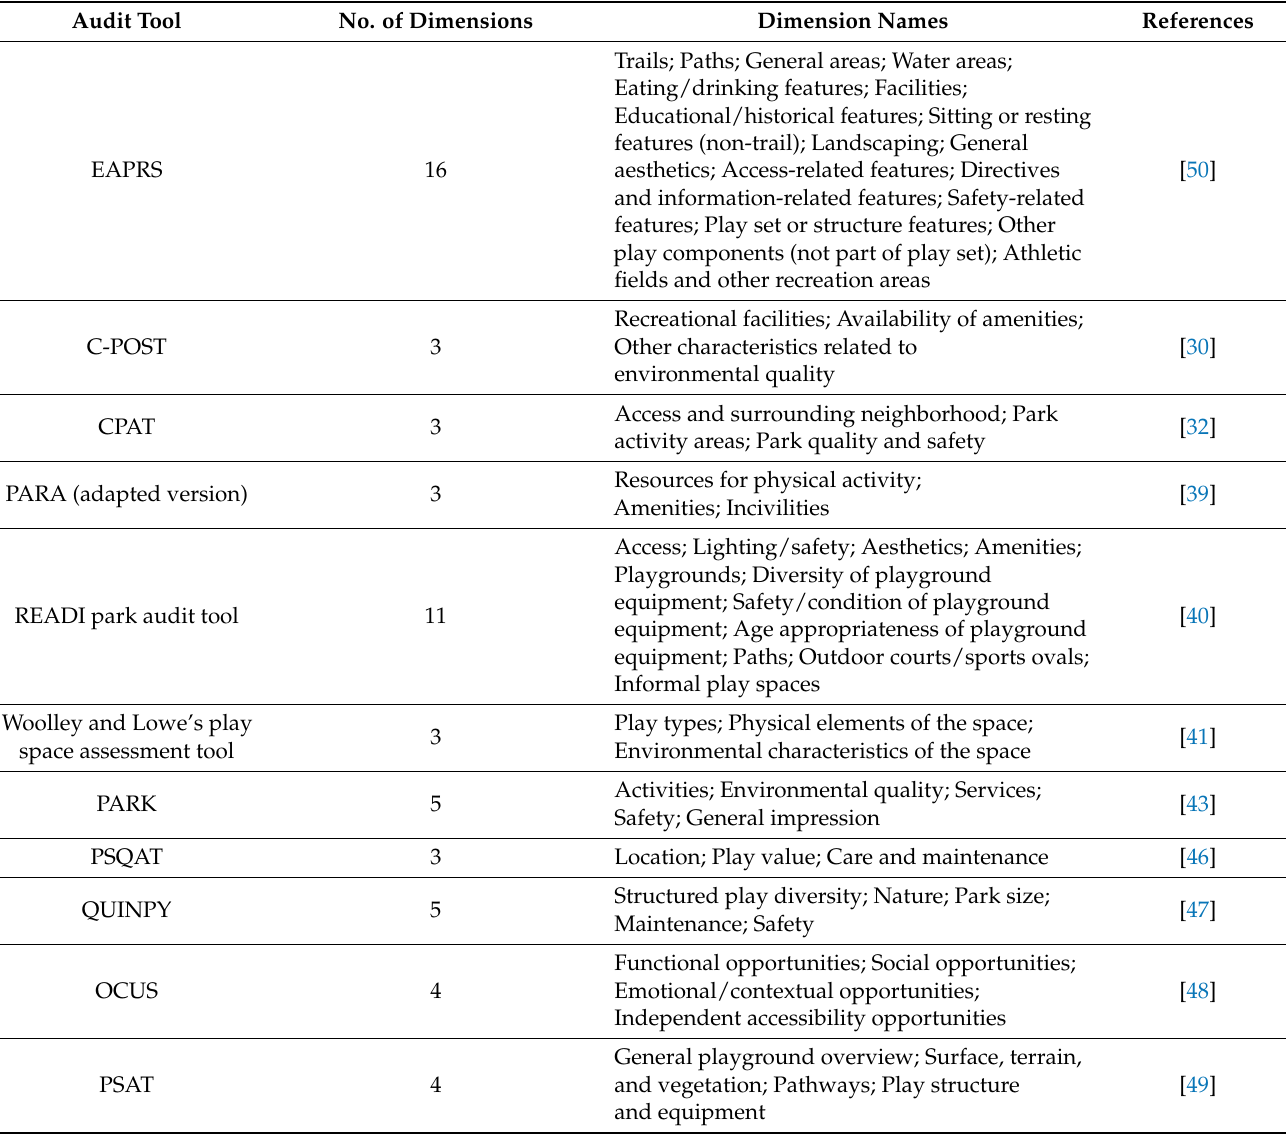
Table 3. Summary of tool